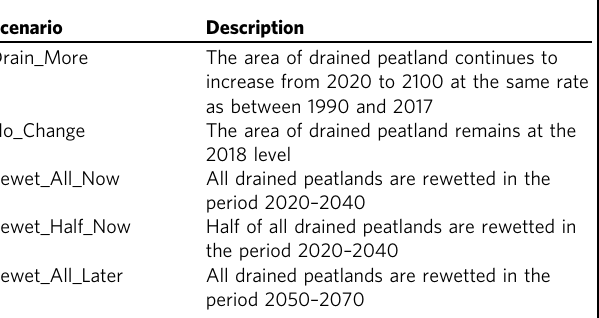
Table 1 Global scenarios of peatland management.